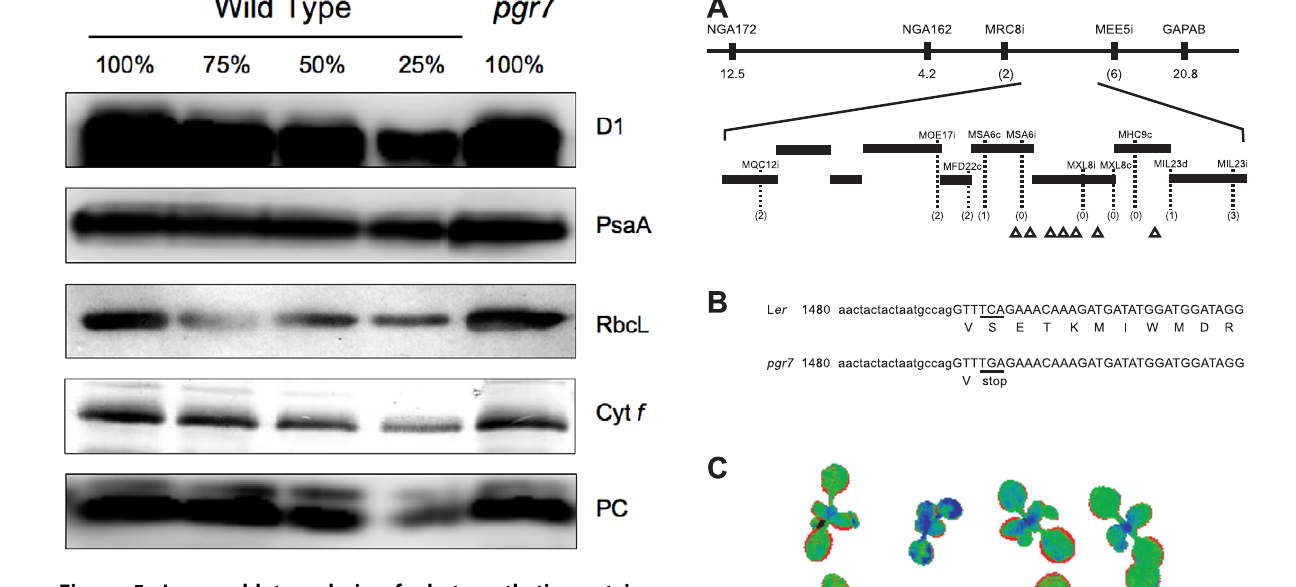
Figure 5. Immunoblot analysis of photosynthetic proteins. Photosynthetic proteins were detected using specific antibodies against D1 (PSII), PsaA (PSI), Cyt f (Cytochrome b 6 f complex), RbcL (the large subunit of ribulose-1,5-bisphosphate carboxylase/oxygenase), and plastocyanin (PC). The lanes were loaded with chloroplast membranes equivalent to 0.4 m g chlorophyll (100%) from the wild type and pgr7 , along with a series of dilutions of the wild-type sample.